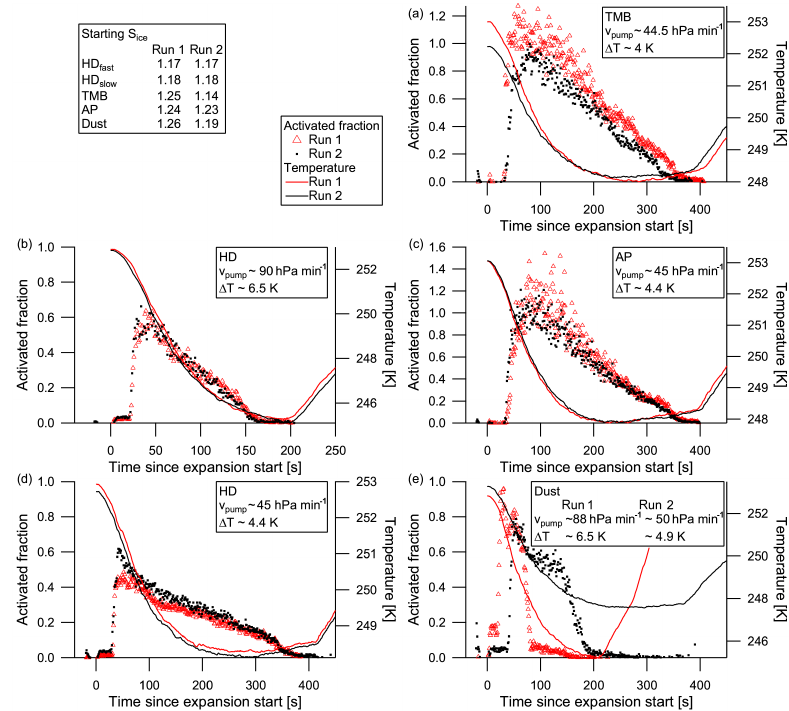
Figure 7. Activated fractions of aerosol to cloud particles for heptadecane (HD; b, d ), TMB (TMB; a ), α -pinene (AP; c ), and dust (e) . The first cloud evacuation run is shown by the red triangles, the second run by black dots. Pump speed and temperature drop during evacuation are given in the